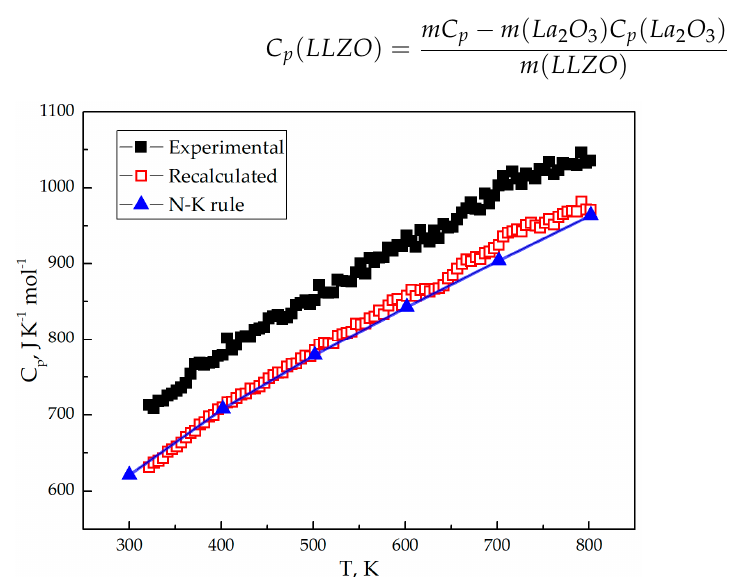
Figure 5. The experimental (filled square), recalculated (unfilled square) and Neumann-Kopp rule (line-connected triangles) heat capacities of Li 7 La 3 Zr 2 O 12 .